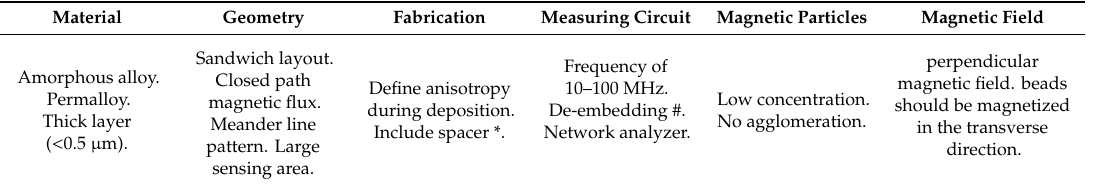
Table 3. Parameters required to produce highly sensitive MI